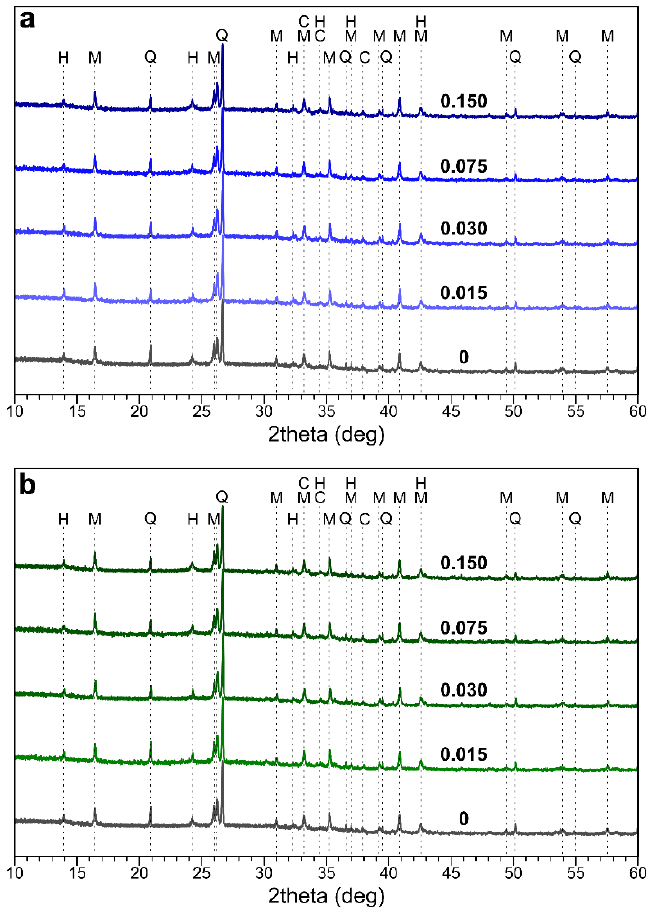
Figure 4. The XRD patterns of geopolymers with borax ( a ) and boric acid ( b ). 0—reference sample without boron (H—hydroxysodalite; M—mullite; Q—quartz; and C—sodium carbonates).